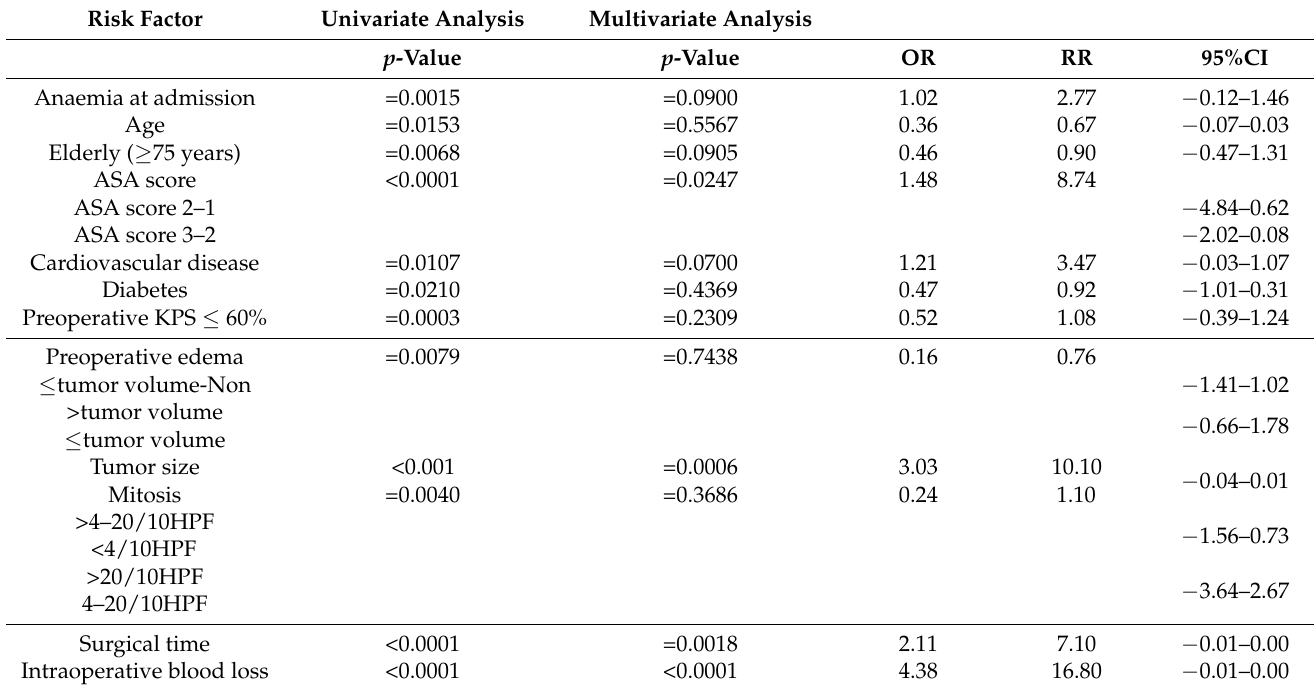
Table 2. Risk factors for RBC